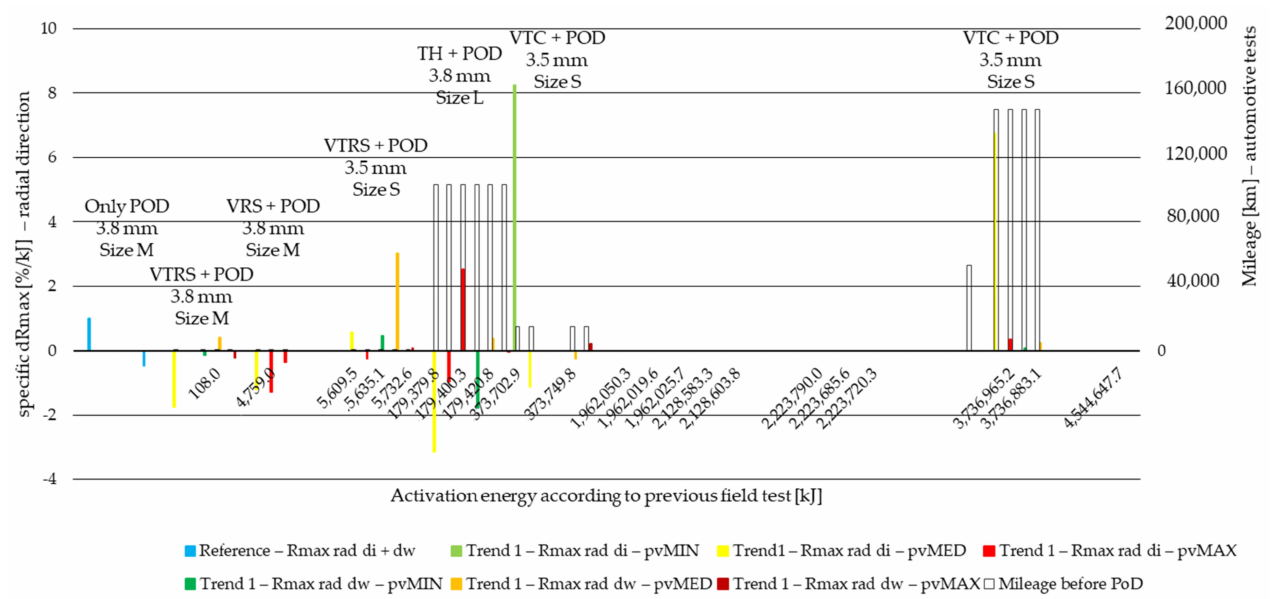
Figure A2. Radial direction PoD specific Rmax difference values of cut material samples from inner and working diameter after minimum, medium and maximum pv level pin-on-disc tests with previous field-test (Table 2) mileage along Joule scale—Trend 1: clutch killer load cases.